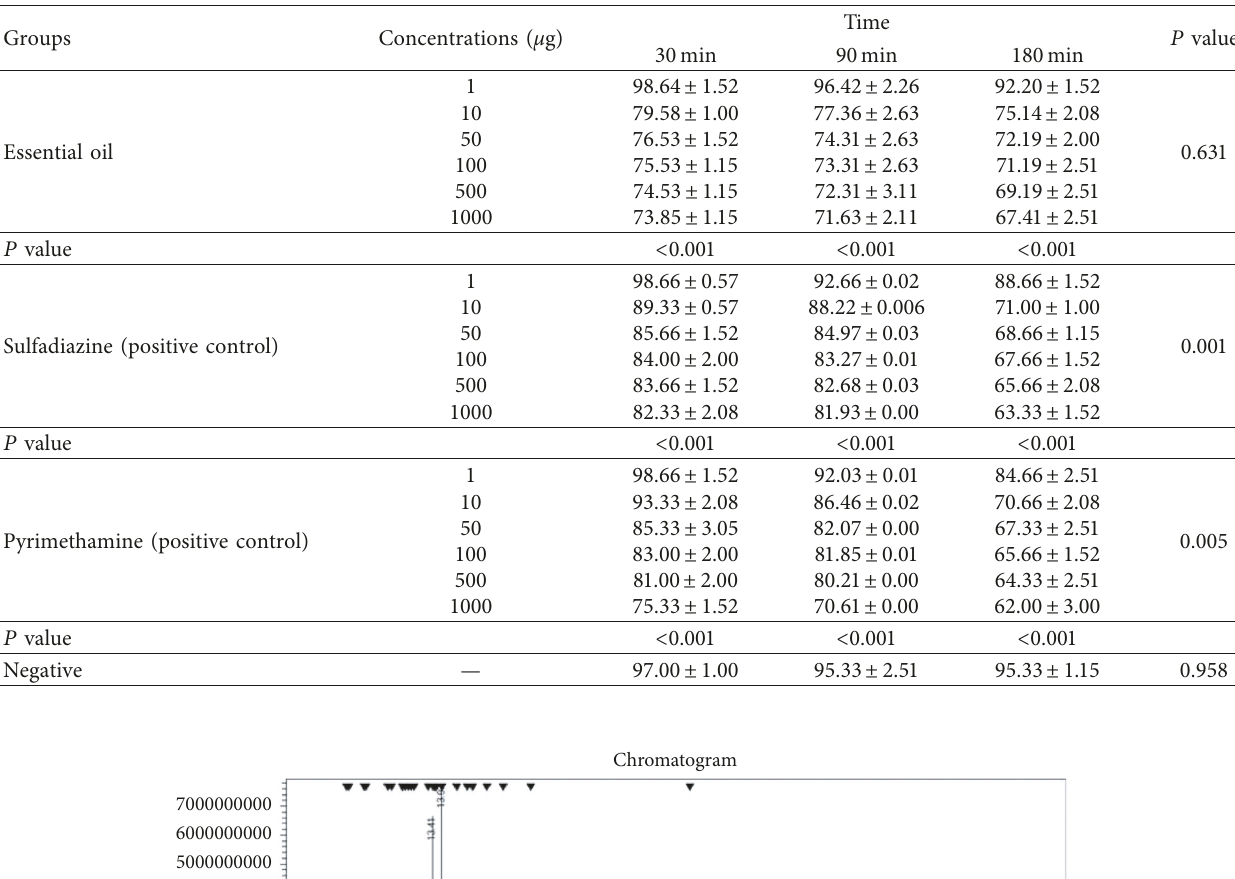
Table 3: The viability between groups with different concentrations and at different times.